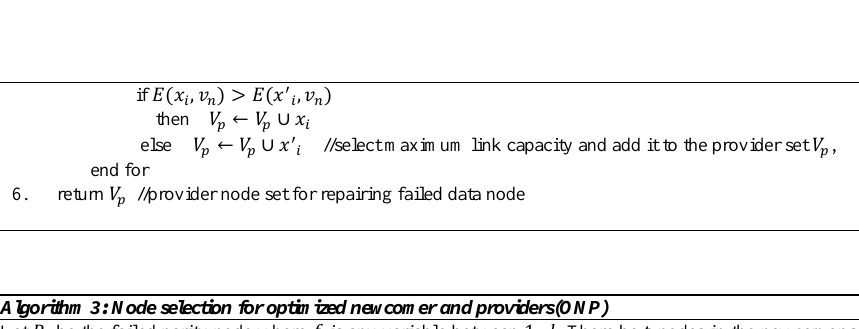
Algorithm 3: Node selection for optimized newcomer and providers(ONP) Let 𝑃 𝑓 be the failed parity node where 𝑓 is any variable between 1..𝑙 . There be 𝑡 nodes in the newcomer set 𝑉 𝑁𝑒𝑤 denoted by 𝑣 𝑗 where 𝑗 = 1..𝑡 . Thus, 𝑉 𝑁𝑒𝑤 = {𝑣 1 ,..,𝑣 𝑗 ,..,𝑣 𝑡 } . For recovering data of failed parity node, first we determine the group to which the failed parity node belongs. All data node pairs 𝑋 𝑖 of this group become providers for recovering the data. This provider set is denoted by 𝑉 𝑝𝑟 . Then we select the most optimal newcomer 𝑣 𝑛 and provider node set 𝑉 𝑝 that connect with maximum link capacity such that the set